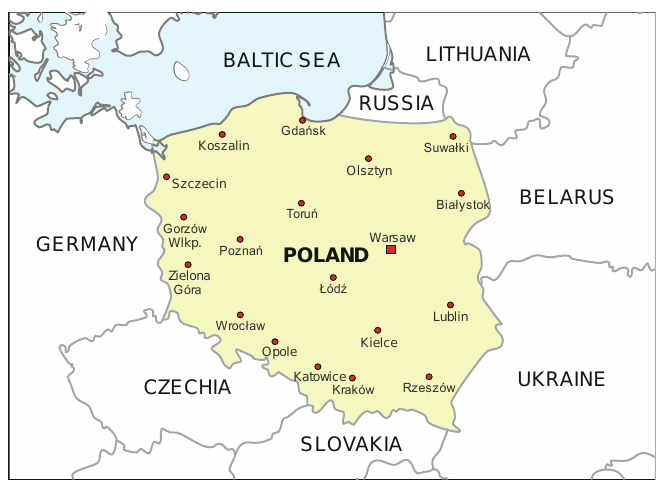
Figure 1. Location of measuring stations.